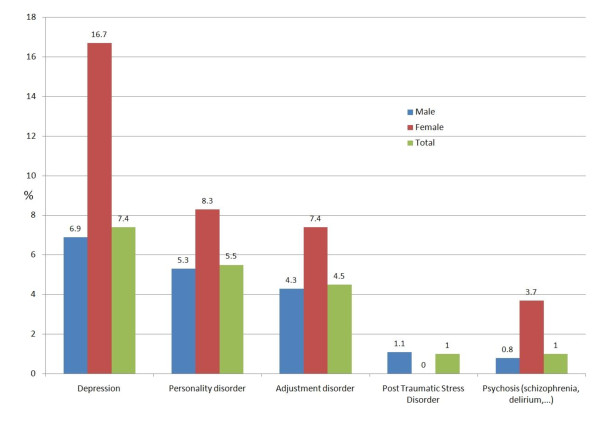
Health problems coded as psychiatry (16.4%; 95%CI 14.8-17.9)